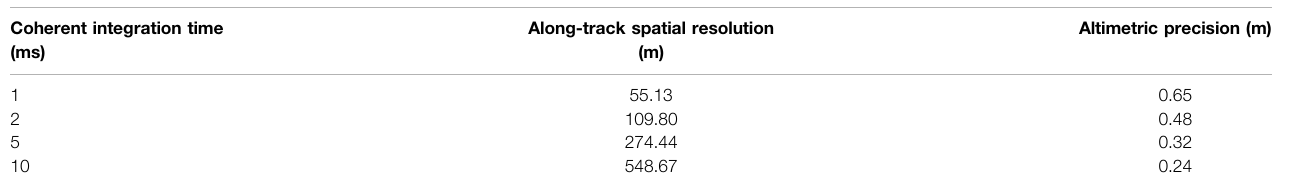
TABLE 1 | The performance of the altimetric precision and the along-track spatial resolution. Coherent integration time (ms)